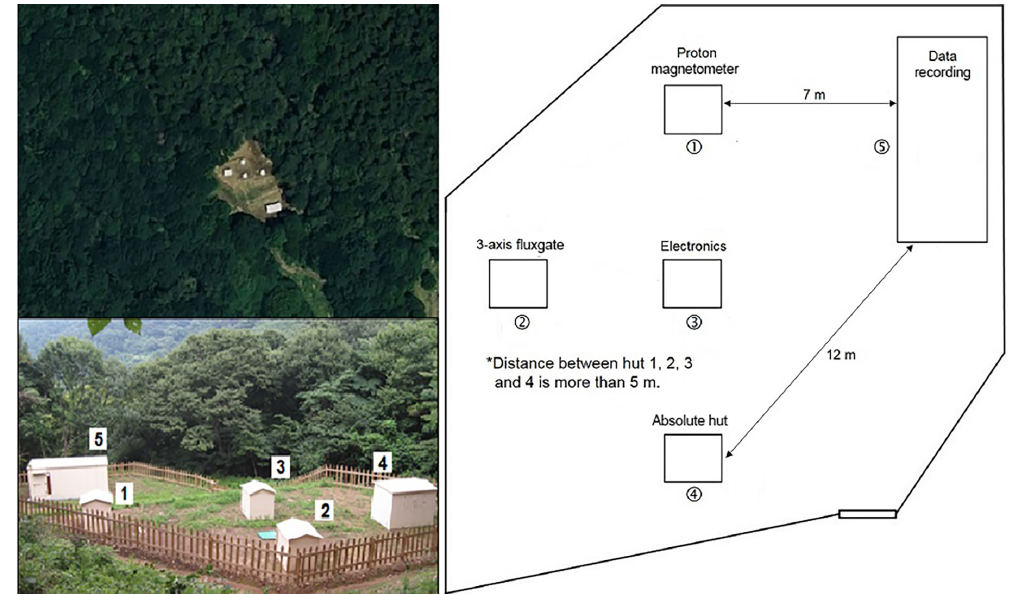
Figure 1. Location and site layout of the CYG observatory. The upper left panel shows the mountainous area where the CYG observatory is located, and the lower panel shows the observatory site. The right panel shows the layout of the observatory site. A scalar magnetometer for total field intensity measurement was installed in hut 1. Hut 2 is used for installation of a three-axis fluxgate magnetometer, and its electronics were placed in hut 3. A pillar used for absolute measurement and which served as a reference point for total field intensity measurement was installed in hut 4. Hut 5 is used as a control room for data acquisition and transmission to a server (Park et al.,